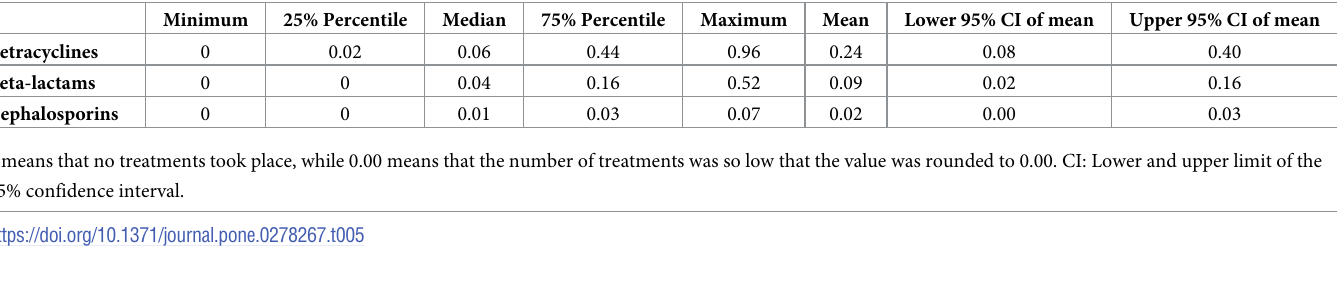
calves from the third week of life up to the fifth month (median: 3.91, mean: 5.36, range: 0.10– 20.18). In the latter age group, however, treatment of enteritis plays a much smaller role than